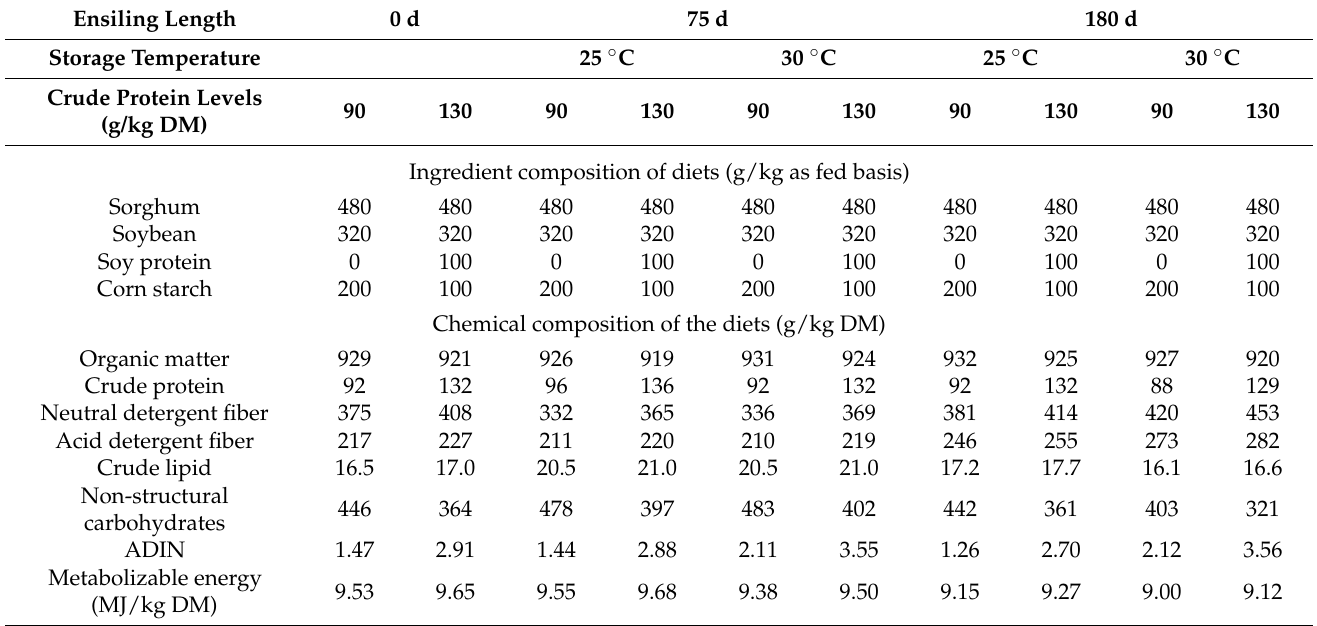
Table 2. Ingredient and chemical composition of the experimental diets at different crude protein levels for the in vitro